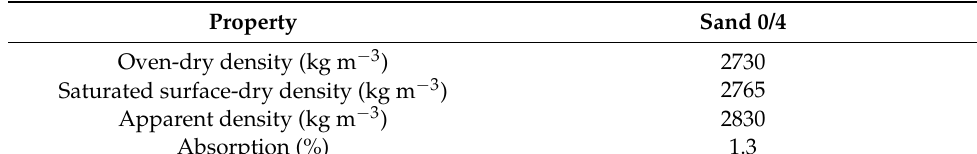
Table 3. Physical properties of aggregate.